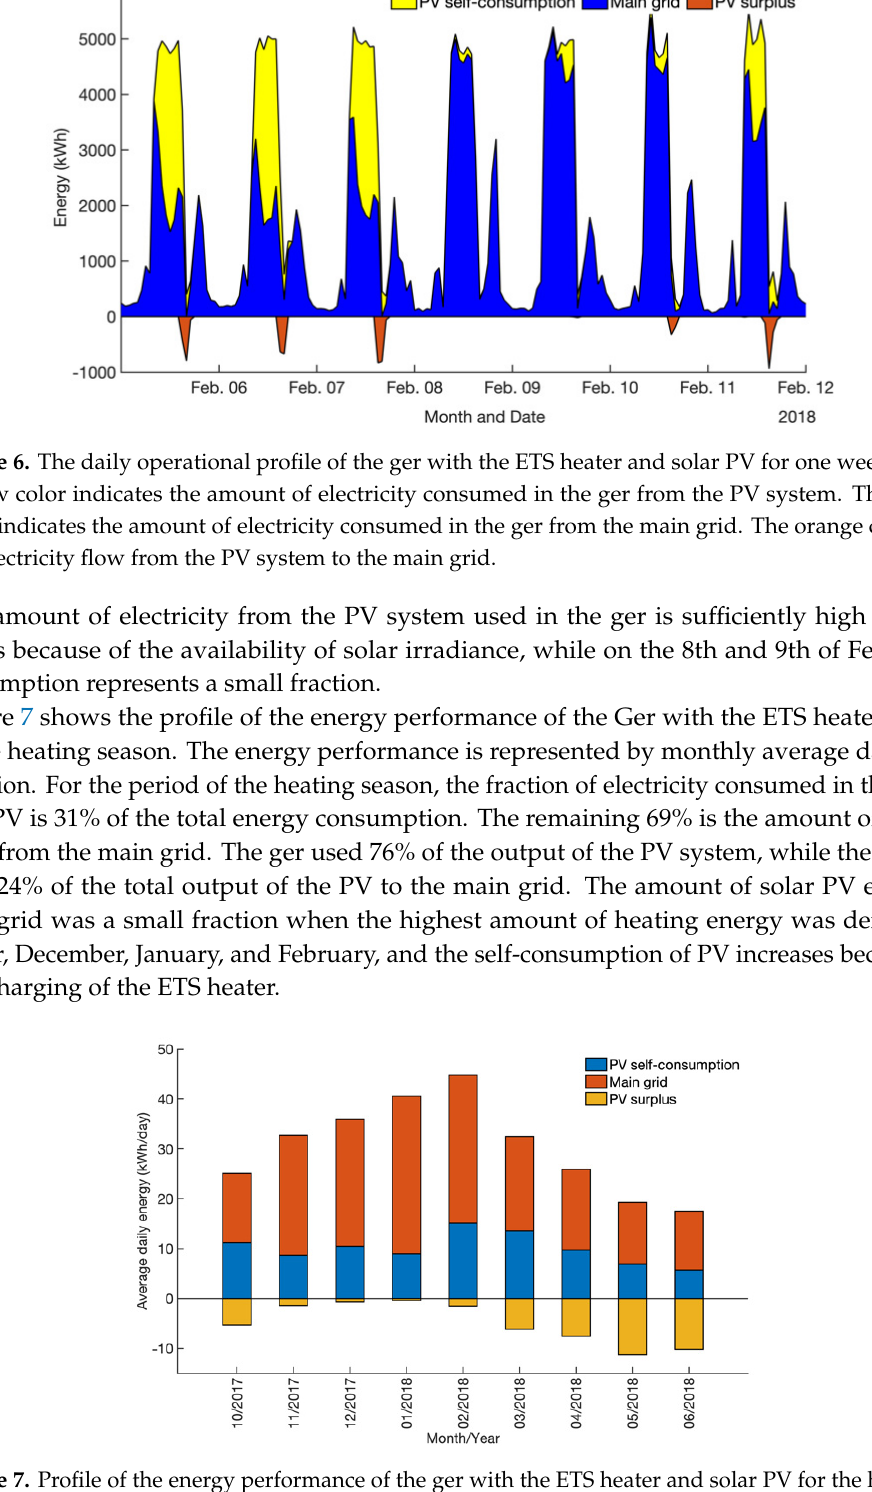
Figure 7. Profile of the energy performance of the ger with the ETS heater and solar PV for the heating season. The energy performance is represented by the monthly average daily energy consumption. The orange color is the amount of electricity consumed in the ger from main grid. The blue color is the amount of electricity consumed in the ger from the PV system. The yellow color is the electricity flow from the PV system to the main grid.